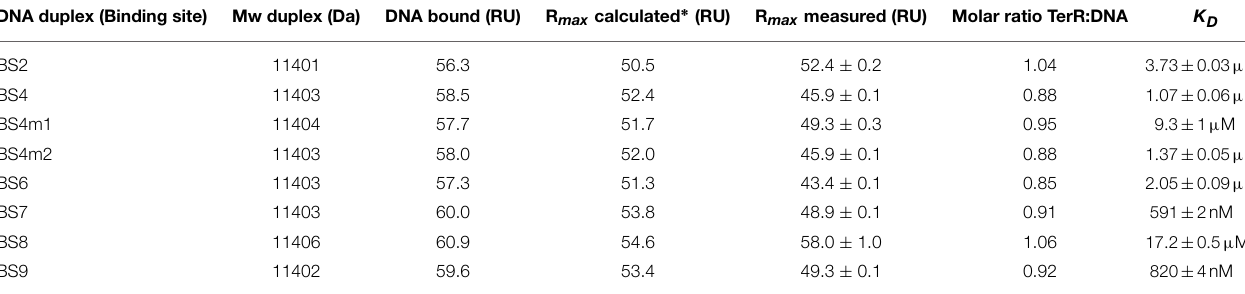
TABLE 2 | Dissociation constants and stoichiometry of analyzed TerR 43 − 138 :DNA interactions. DNA duplex (Binding site) Mw duplex (Da) DNA bound (RU) R max calculated ∗ (RU) R max measured (RU) Molar ratio